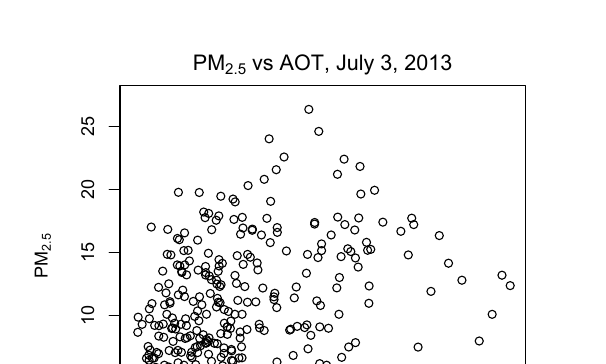
Figure 2. Three swaths covering the continental United States on an illustrative summer day.